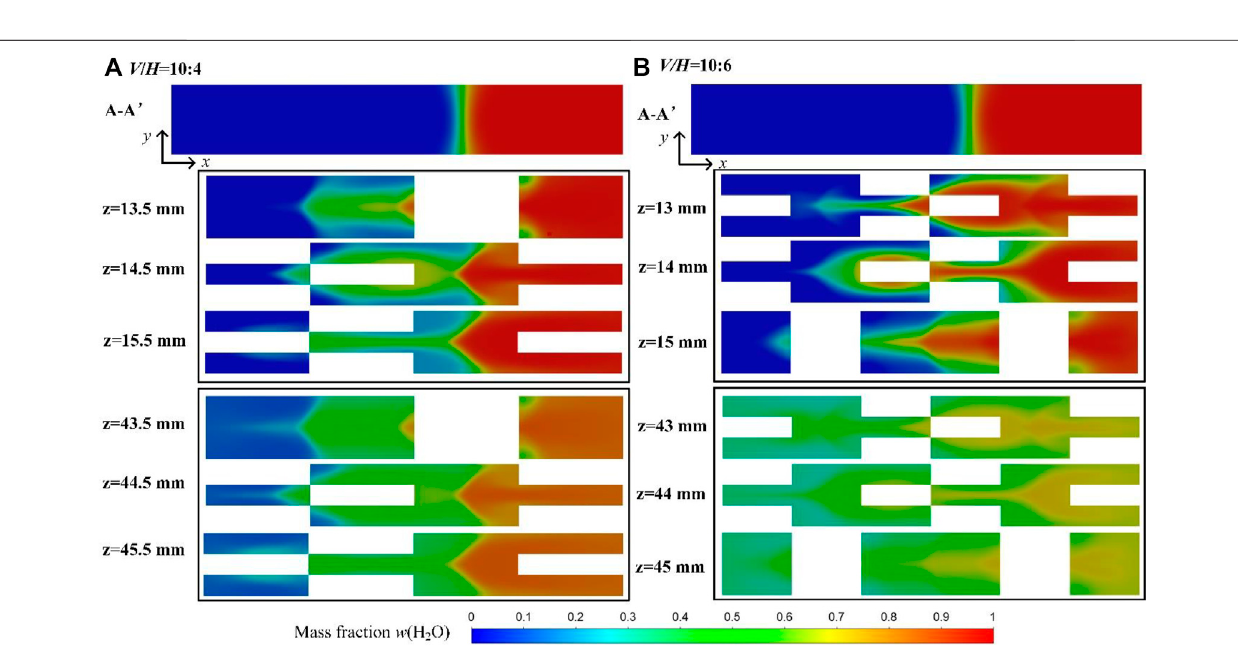
Frontiers in Chemical Engineering |